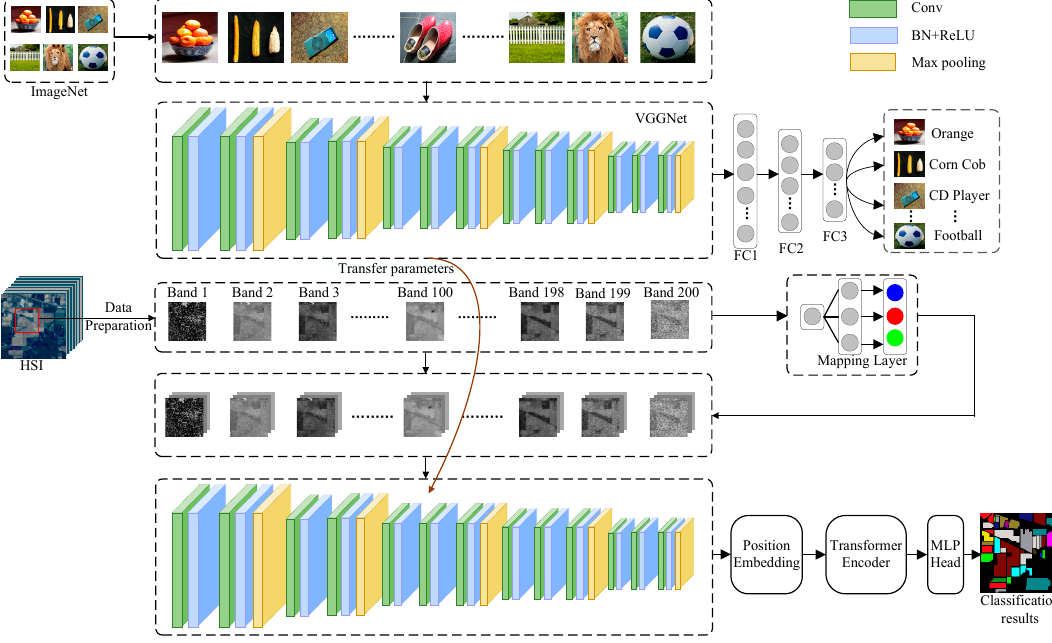
Figure 3. The framework of T-SST for HSI classification.